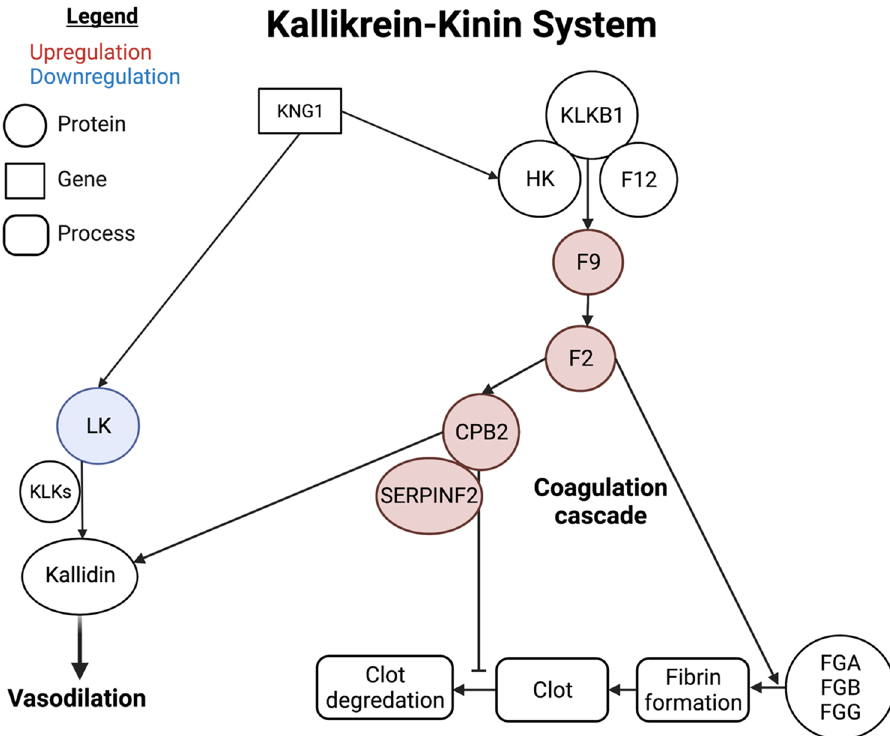
Figure 4. Biological model for post-heart transplant survival regulated by the kallikrein-kinin system (KKS). Our predictive analyses converge on a biological role of the Kallikrein-kinin system (KKS) in patient survival post-transplant. Two pathways of the KKS diverge at kininogen (KNG1) transcription into high molecular weight (HK) or low molecular weight (LK) kininogen. LK is cleaved by tissue kallikreins (KLKs) into kallidin and contributes to vasodilation. HK forms a complex with plasma kallikrein and factor 12 to catalyze coagulation. The waterfall cascade involves factor F9 and factor F2 which, in conjunction with fibrinogens, activate fibrin formation. As clotting is upregulated by the increased expression of predictive proteins, the proteinases CPB2 and SERPINF2 inhibit the degradation of clots. Figure made with